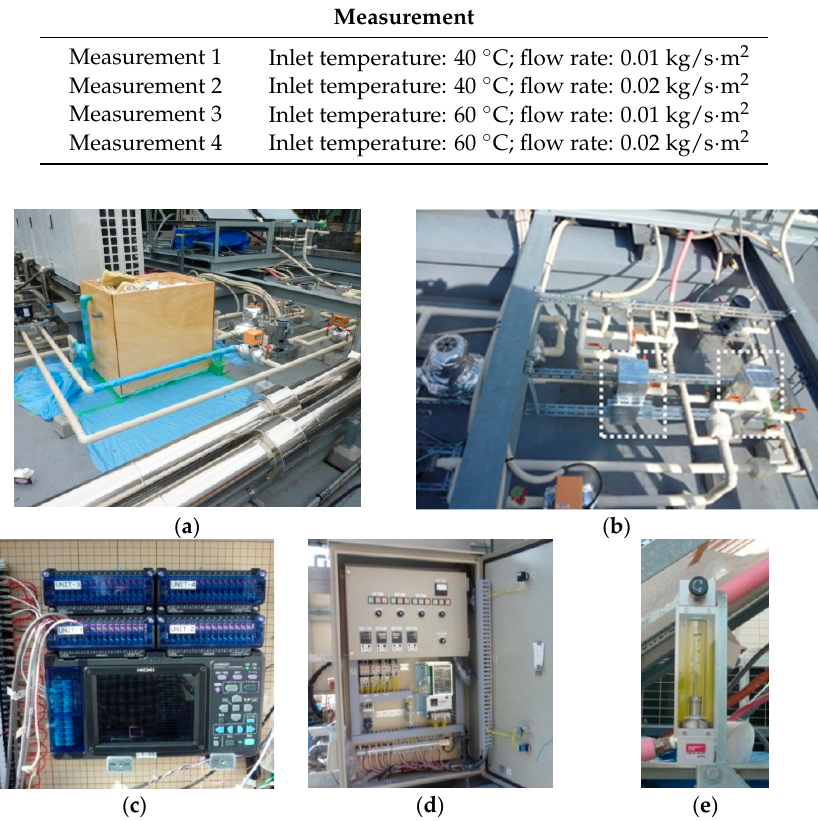
Figure 3. Auxiliary experimental equipment. ( a ) Hot water tank and pumps; ( b ) Heat exchanger; ( c ) Data logger; ( d ) Control panel; and ( e ) Needle valve.